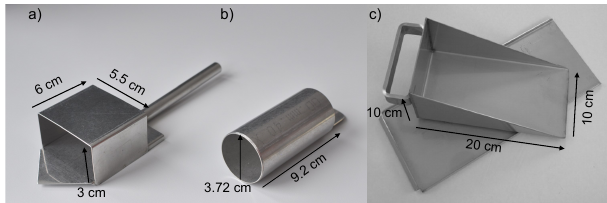
Figure 1. Density cutters used at the MicroSnow workshop: (a) box, (b) cylinder, and (c) wedge (from http://snowmetrics.com/shop/